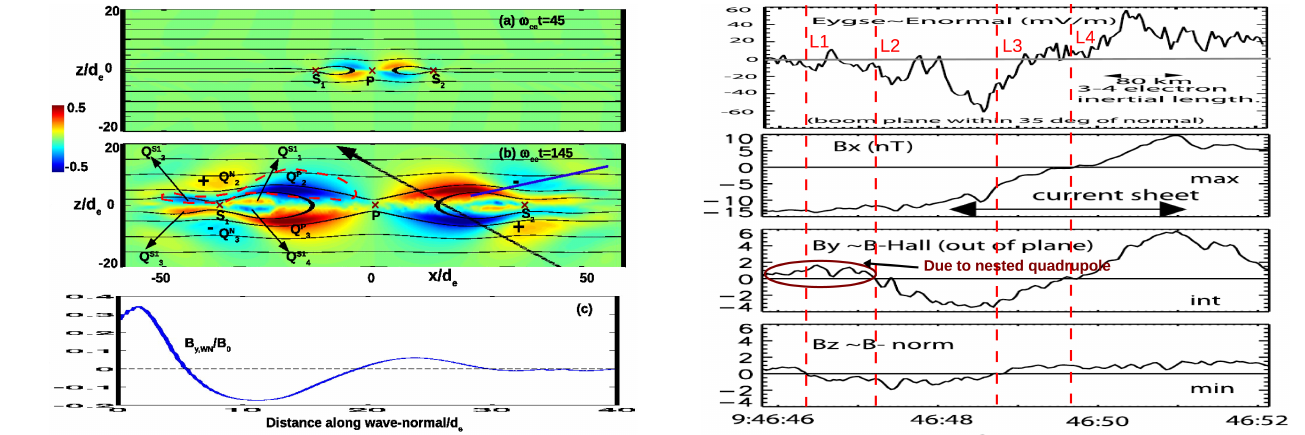
Figure 2. Observation of electron-scale current sheet by Cluster (adopted from Fig. 3a of Wygant et al., 2005). Top panel: E y GSE ( y component of electric field in GSE coordinate system). Three bottom panels: x , y and z components of magnetic field in bound- ary normal coordinate system. Vertical dashed lines ( L 1 − L 4 ) mark the zero crossings of the magnetic field